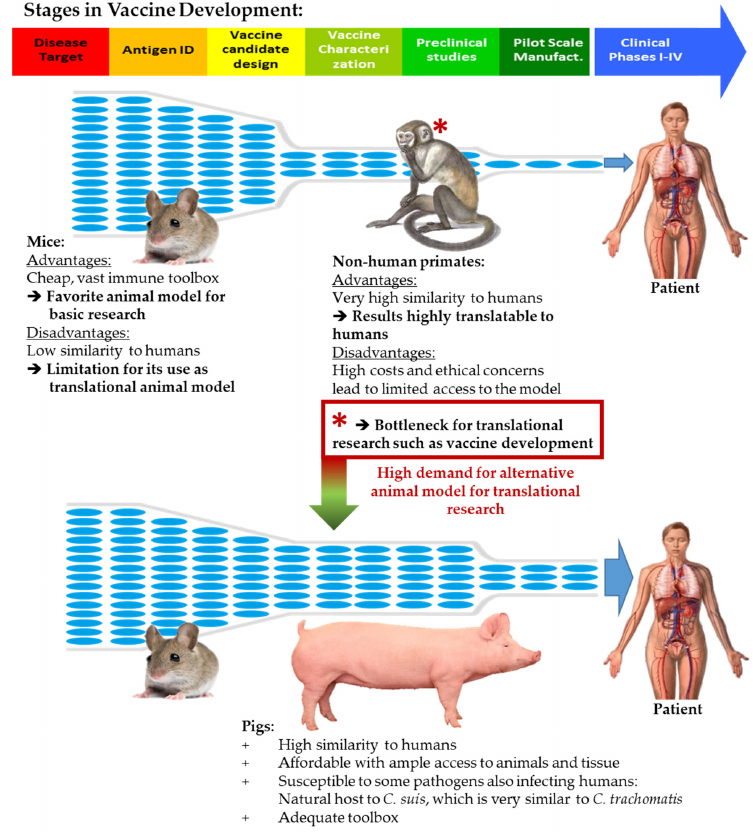
Figure 1. Animal models for vaccine development. The various animal models have advantages and disadvantages during the process of vaccine development. While the associated costs and vast immune toolbox of mice make them an excellent model for basic research, non-human primates are an excellent choice for translational research. Due to high costs and ethical concerns, access to non-human primates is limited, creating a bottleneck for vaccine development. The pig has several advantages as a biomedical translational animal model and can open the bottleneck to advance promising vaccine candidates into clinical trials. The stages in vaccine development were adapted from https://www.niaid.nih.gov/research/vaccine-development-pipeline. With eight chlamydia vaccine studies, koalas are the second most frequently used animal model. However, these studies are concentrated on C. pecorum , which naturally infect koalas and lead to devastating reproductive issues. Thus, the end goal for many koala vaccine studies is protection of this iconic Australian marsupial. Pigs have been used to study Ct infections and vaccine development since 2005 The third most frequently used animal model for Ct vaccine development is the pig—both commercial and minipig breeds. The pig has several advantages as a biomedical translational animal model [4,9] and it significantly contributed to the study of sexually transmitted diseases including Ct vaccine development [10 – 15]. Pigs have a similar size, physiology, and hormonal reproductive cycle